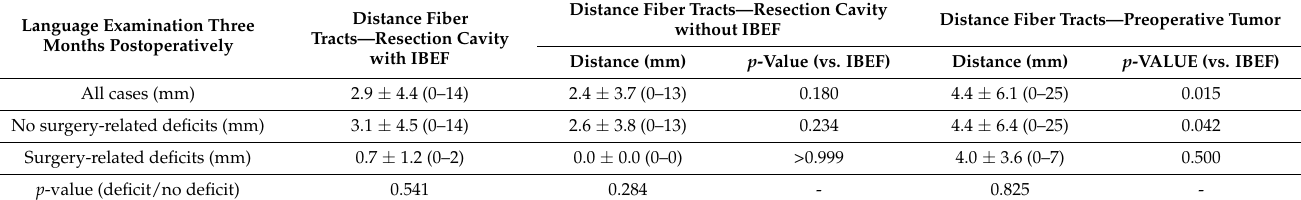
Table 2. Distance between the language eloquent fiber tracts and the intraoperative MRI resection cavity. This table shows the distance between the language eloquent fiber tracts and the resection cavity depicted in the intraoperative MRI. Cases without surgery-related deficits at the 3 months follow-up (FU) (including patients with transient surgery-related deficits) are compared with cases with permanent surgery-related deficits at 3 months FU (including patients with surgery-related deficits lost to FU). Distances are shown for measurements with ioMRI-based elastic fusion (IBEF), without IBEF, and preoperative measurements.